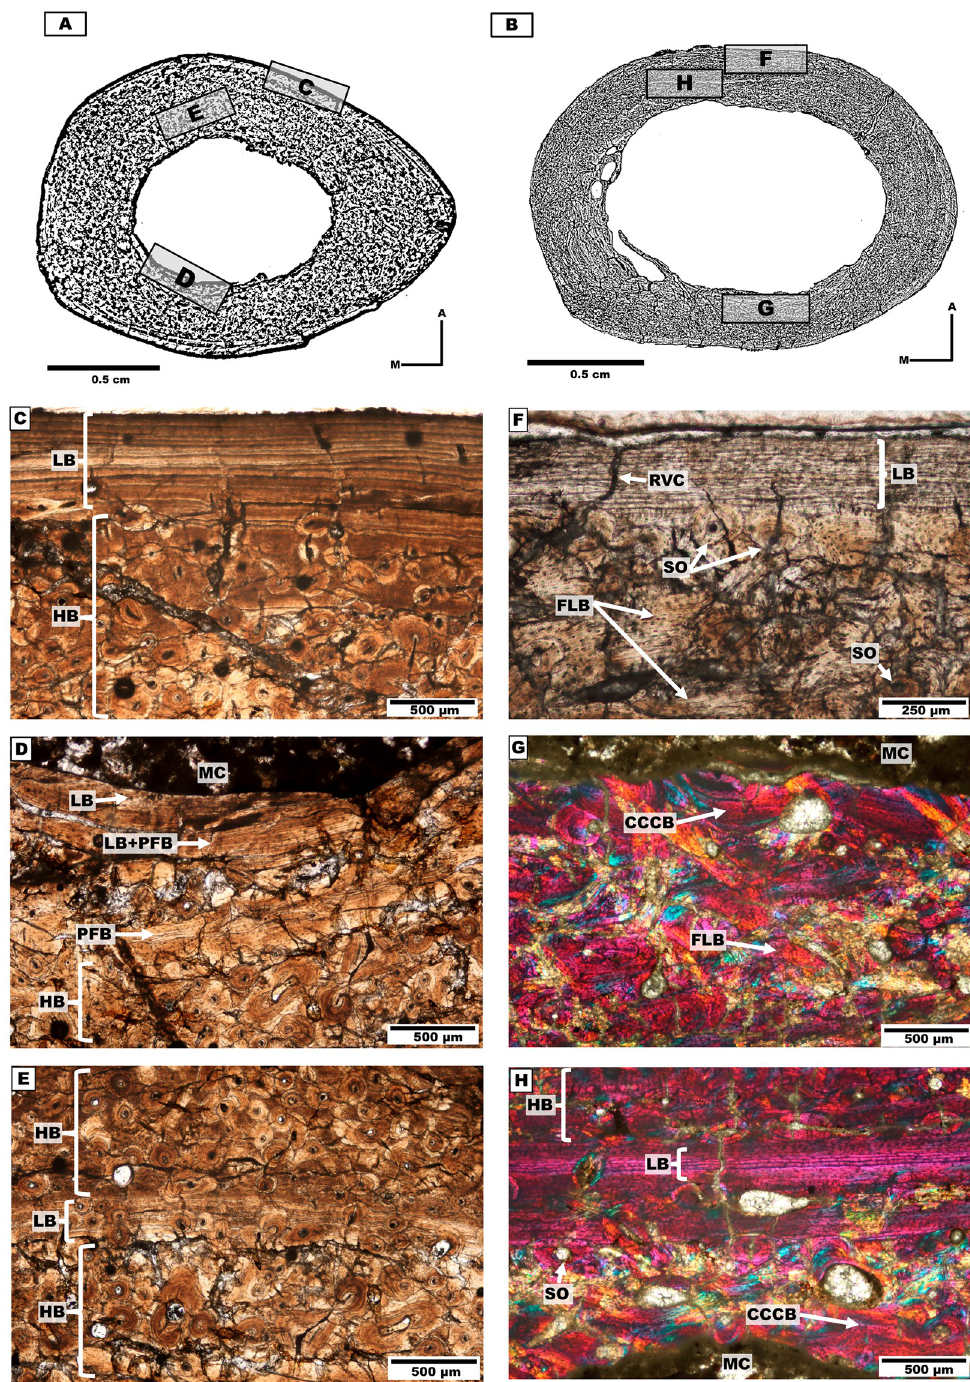
Fig 8. Femurs cross-sections of the mesotheriine notoungulate Caraguatypotherium munozi from middle Miocene of Caragua, Huaylas formation. (A) Femora cross-section for individual 5 (GEOUACH.HS.FI.2); (B) Femora cross-section for individual 7 (GEOUACH.HS.FD.1); (C) Pericortical region presence of LB and intracortical region presence of HB (GEOUACH.HS.FI.2); (D) LB and PFB in the Endocortical region (GEOUACH.HS.FI.2); (E) In the centre of intracortical region presence of LB between HB (GEOUACH.HS.FI.2); (F) Pericortical region, presence of LB in the external surface, FLB in the intracortical region and SO (GEOUACH.HS.FD.1); (G) CCCB in the endocortical region and FLB (GEOUACH.HS.FD.1); (H) In the centre of intracortical region presence of LB between HB (GEOUACH.HS.FD.1). For abbreviations refer to Fig 4.